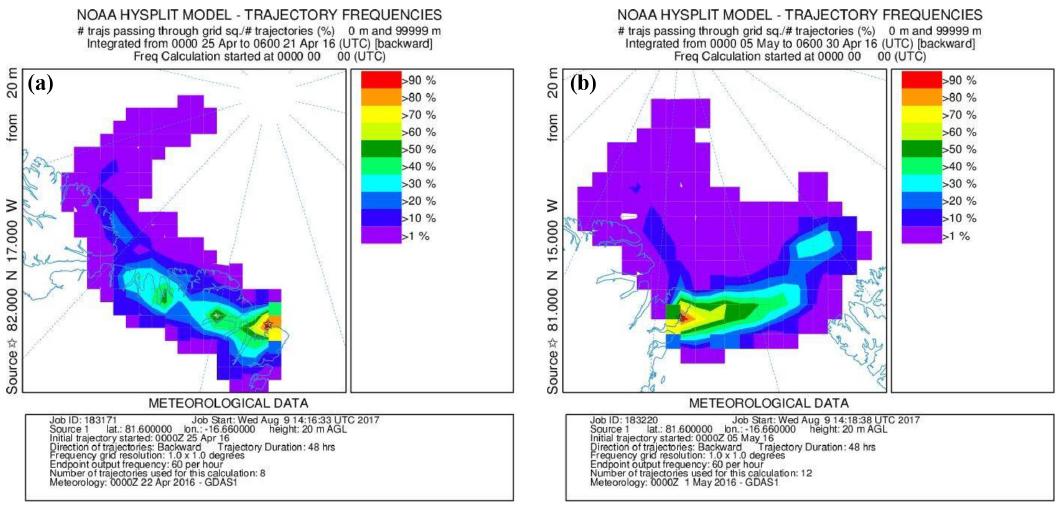
Figure 4. Trajectory frequencies showing the number of trajectories passing through a grid. The resolution is 1 ◦ . (a) Data for 21 to 25 April. (b) Data for 30 April to 5 May.